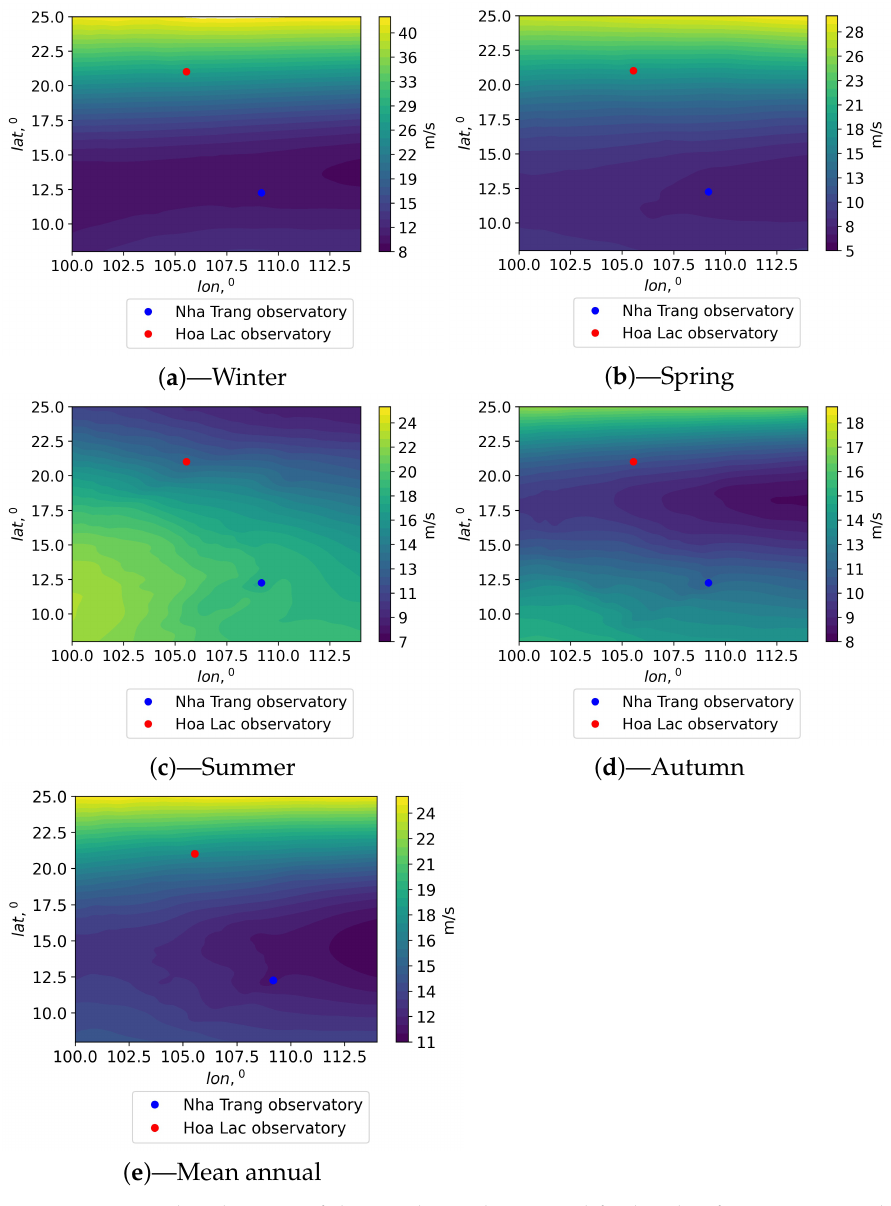
Figure 1. Space distributions of the wind speed averaged for heights from 100 to 200 hPa in the region of the Nha Trang observatory and the Hoa Lac